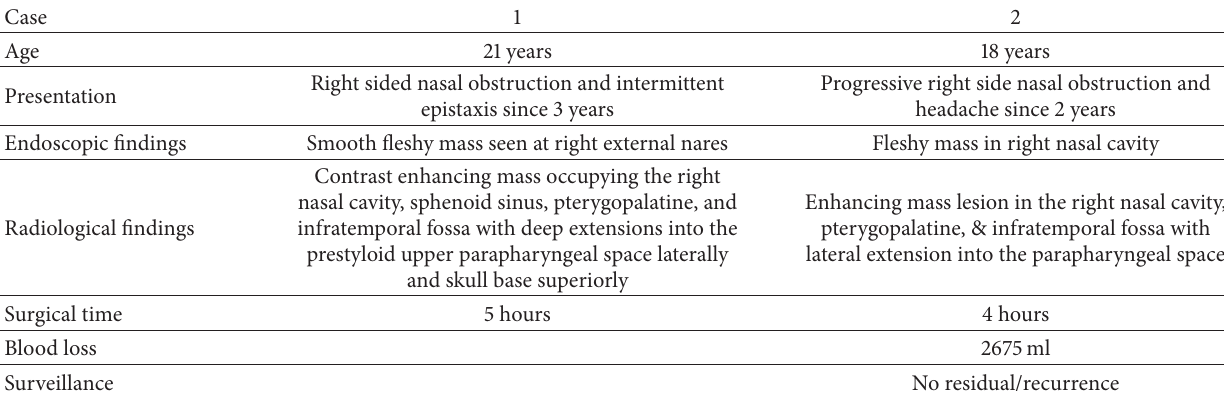
Table 1: Summary of patient